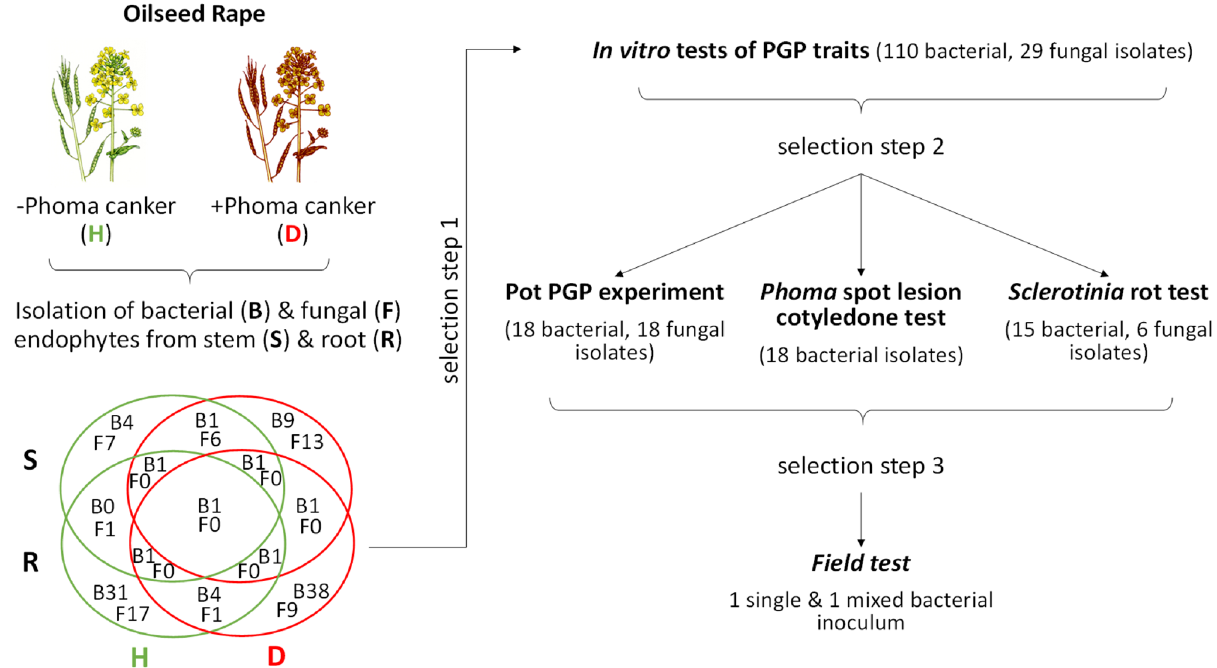
Figure 1. General outline of the study and Venn diagram of the isolated culturable endophytes from symptomless oilseed rape (H, healthy) and oilseed rape showing symptoms of Phoma Stem Canker (D,